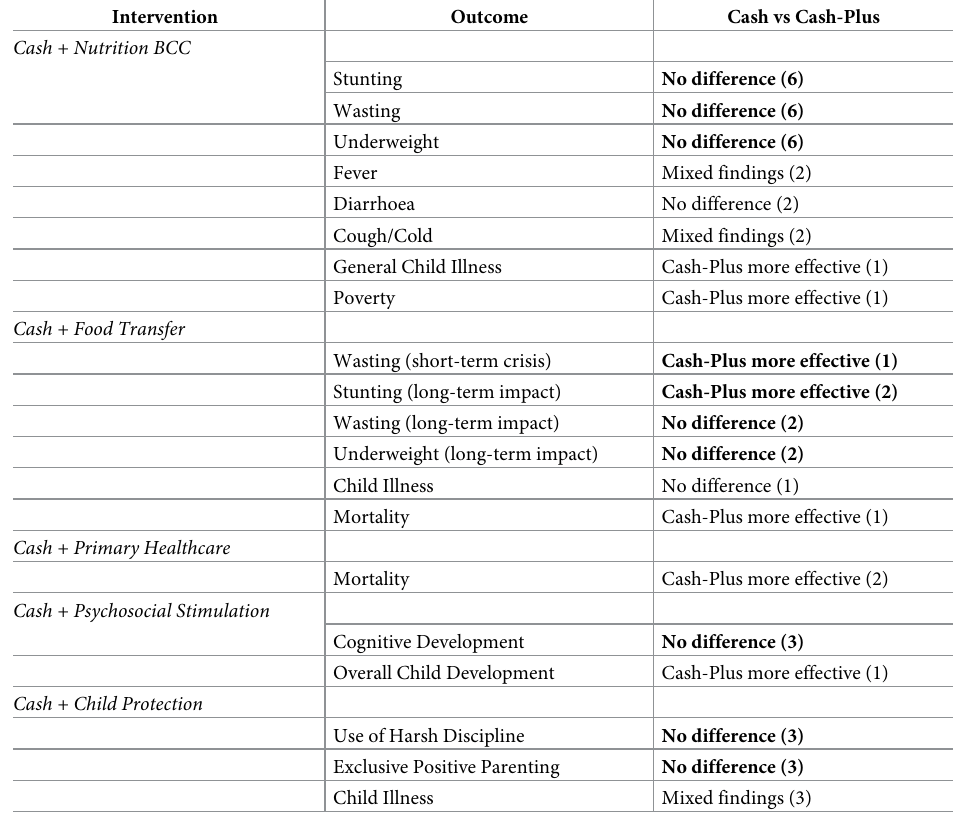
Meta-analysis findings are